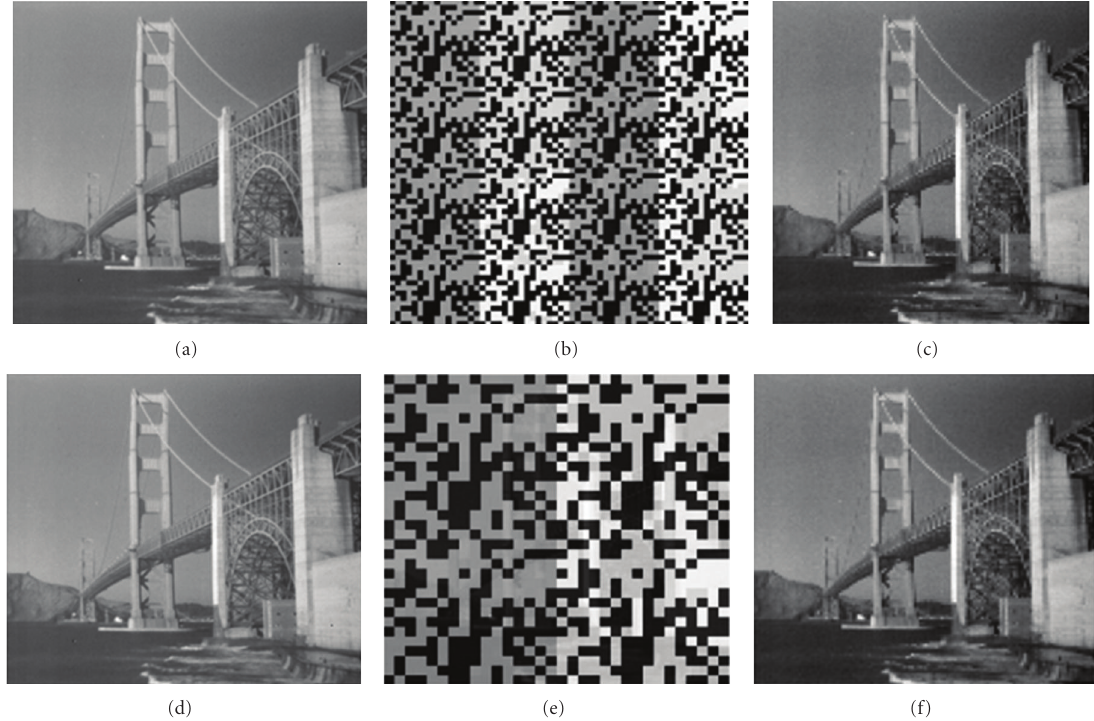
Figure 5: Results of application of chaotic algorithm to SF.GIF. (a) and (d) original image. (b) Image resulting from encryption with L1 or L2, respectively, using two external encryption keys in the larger size. (c) and (f) Reconstructed image in each